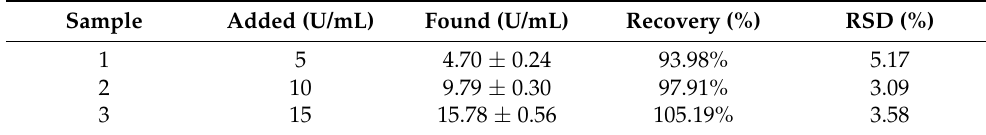
Table 2. Recovery experimental results of human serum samples ( n =